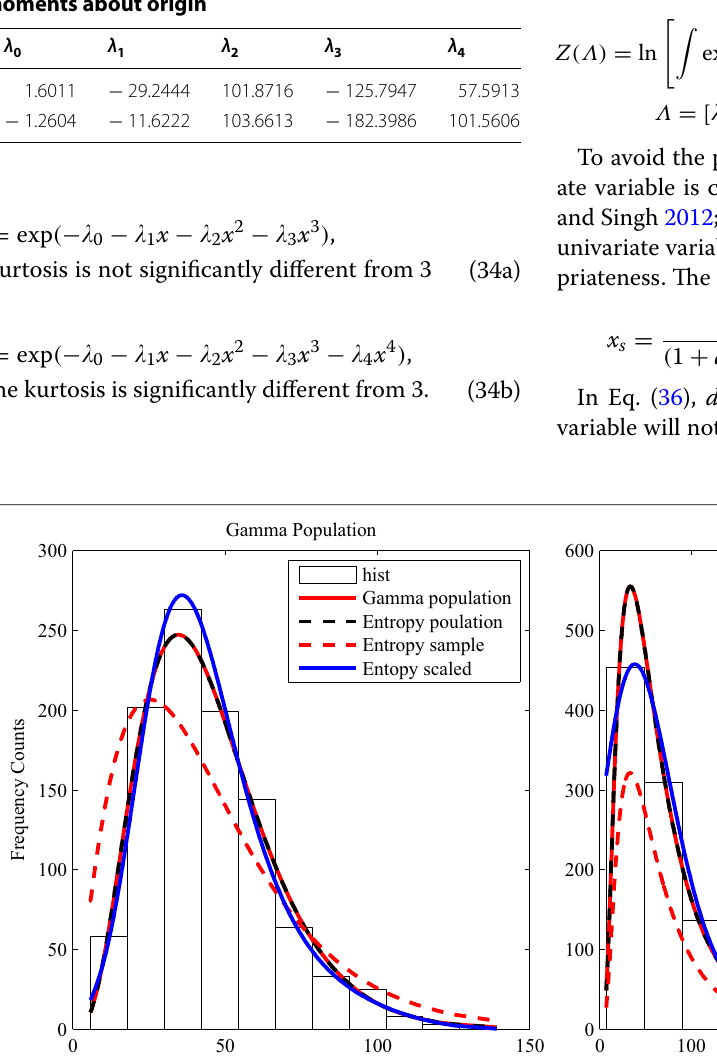
Table 3 Chi square univariate goodness-of-fit results (comparing to the population parameters)